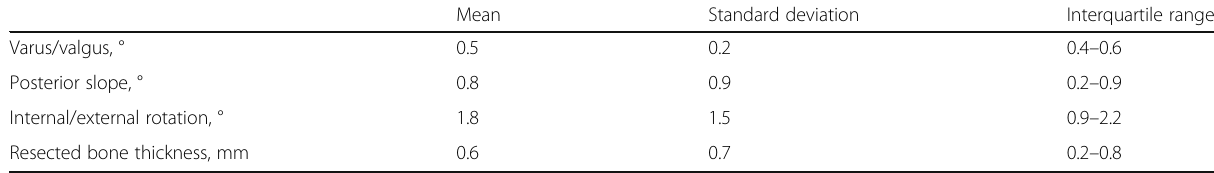
Mean Standard deviation Interquartile range